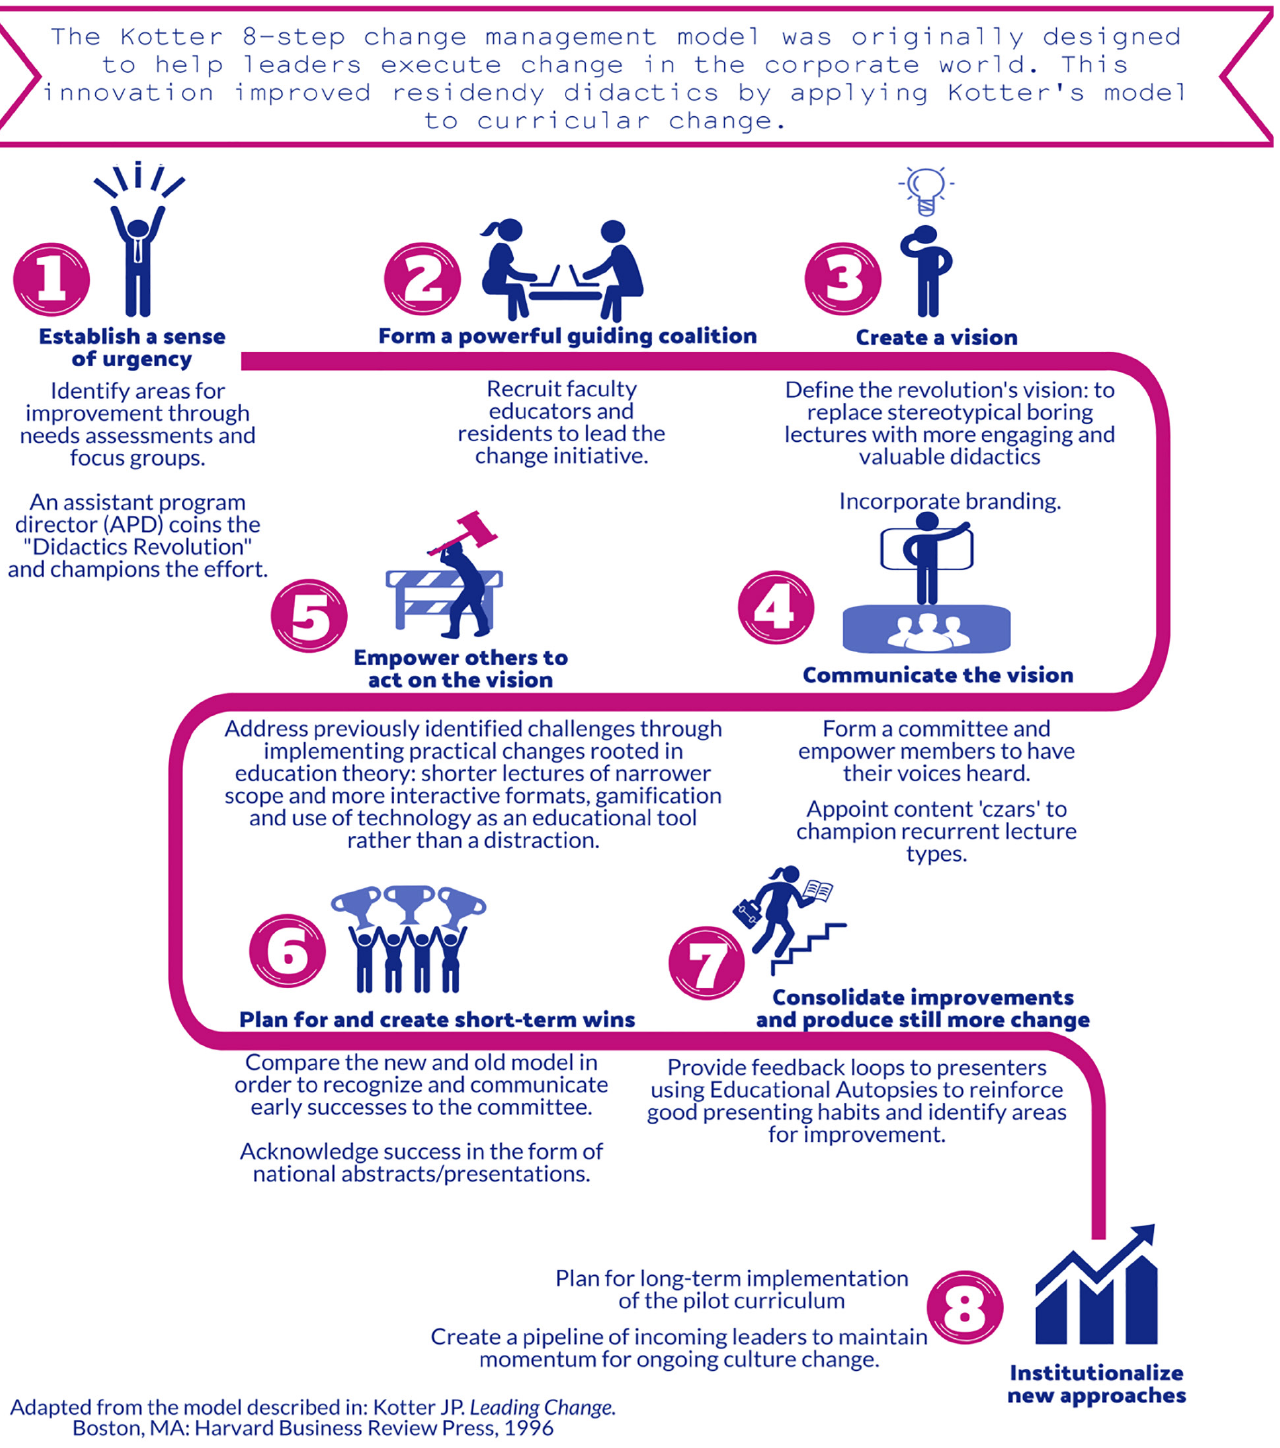
Figure 1. Method of improving EM residency didactics utilizing Kotter’s change management model